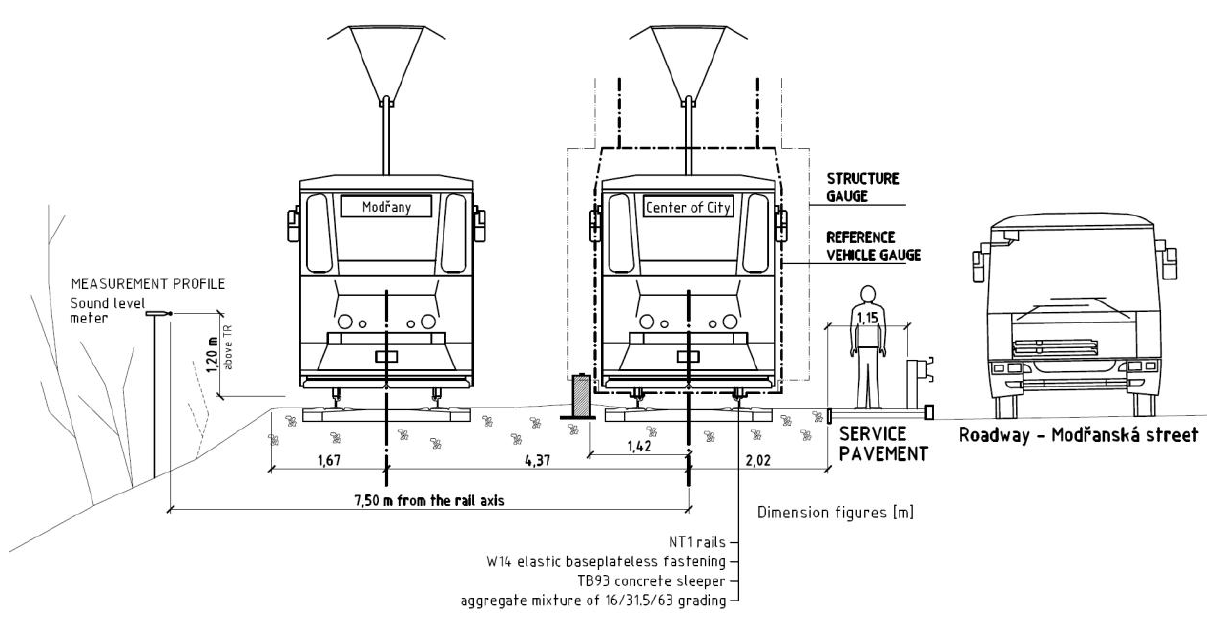
Figure 4. Characteristic section at the point of the noise-absorbing screen placement.